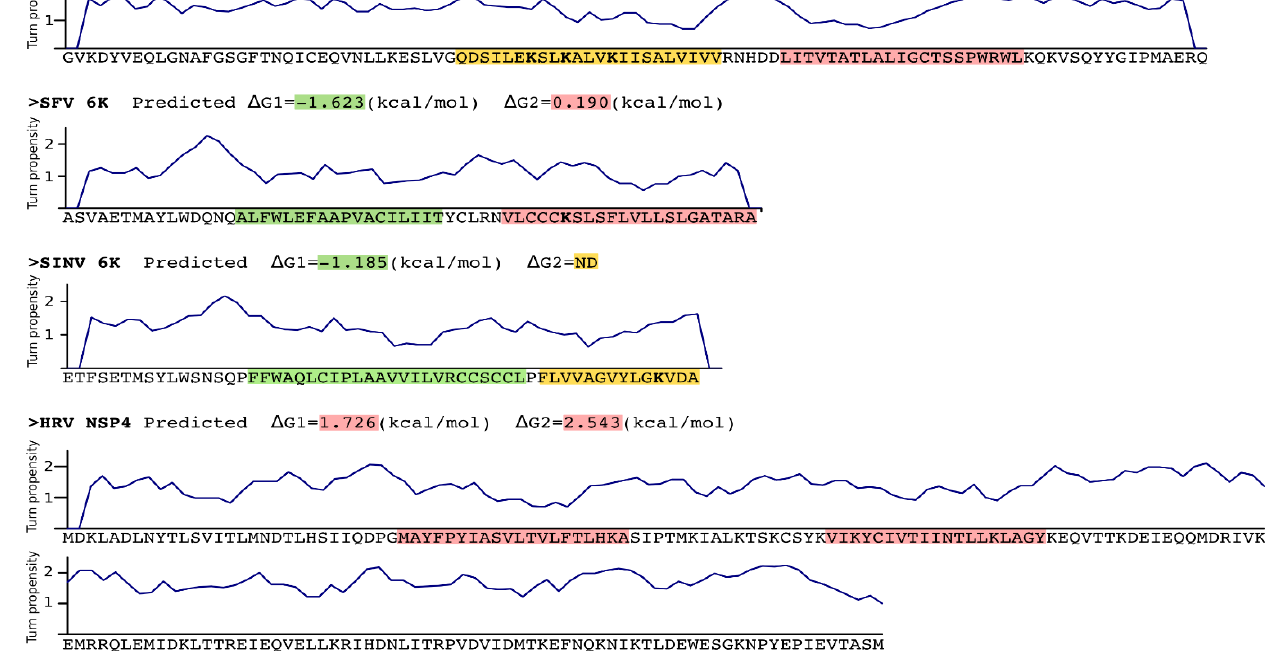
Figure 2. Sequence analysis of Class II viroporins. Sequence, in FASTA format, of the Class II viroporins included in this review. The putative TM segments found by the ∆ G Prediction Server [13] and their predicted ∆ G values (kcal/mol) are highlighted in green (indicating a negative ∆ G value) or in red (positive ∆ G value). Those TM segments for which existence there are evidences (experimental or computational) but were not detected (ND) by the algorithm are highlighted in yellow. The Lys residues within the TM segments are displayed in bold. A turn propensity plot is depicted above each protein sequence. For this analysis the turn propensity at each position was calculated using the data on Monné et al. and a slide window of 5 amino acids. PV1 Poliovirus 1, HCV Hepatitis C virus, CVB3 Coxsackievirus B3, SFV Semliki forest virus, SINV Sindbis virus, HRV Human rotavirus A.